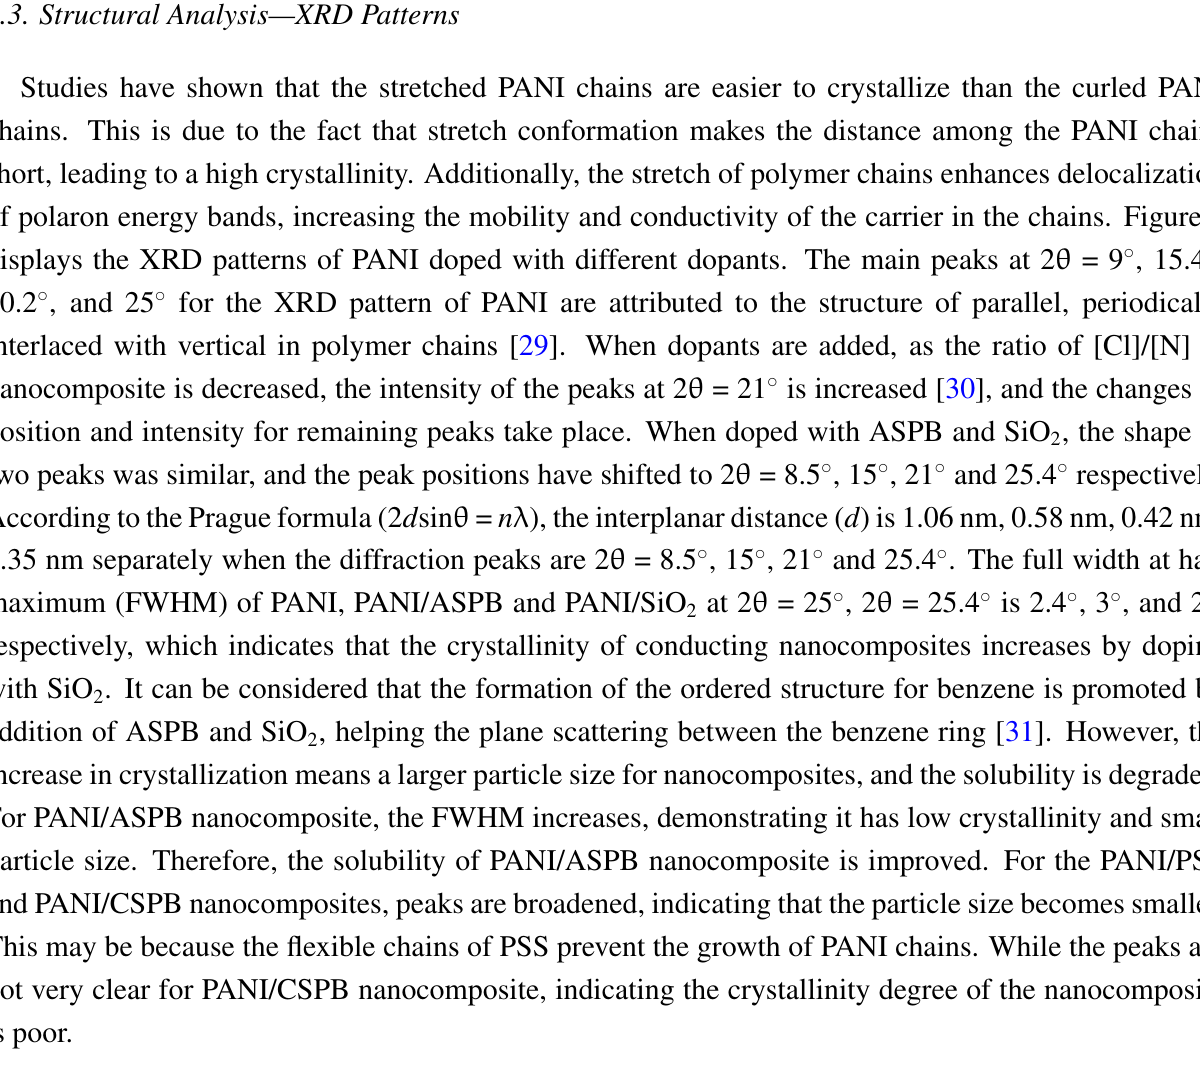
Figure 3. UV-VIS spectra of PANI, PANI/ASPB, PANI/PSS, PANI/CSPB, and PANI/SiO 2 nanocomposites.